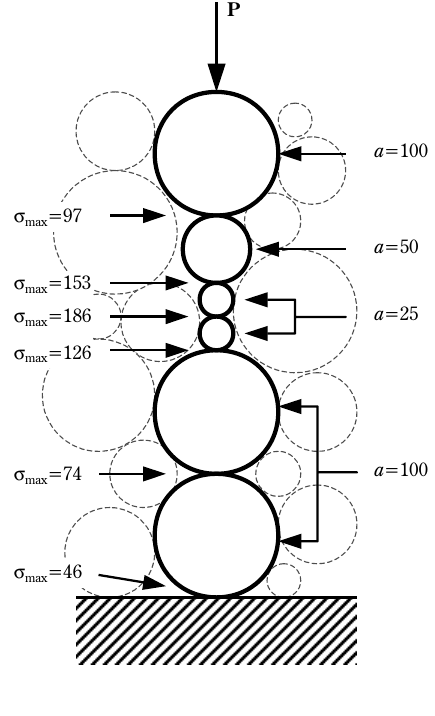
Fig. 6 Schematic of a stress pathway in an assembly of granules. The load follows a chain of spheres of different sizes. The relative stress (in arbitrary units) in the contacting spheres is